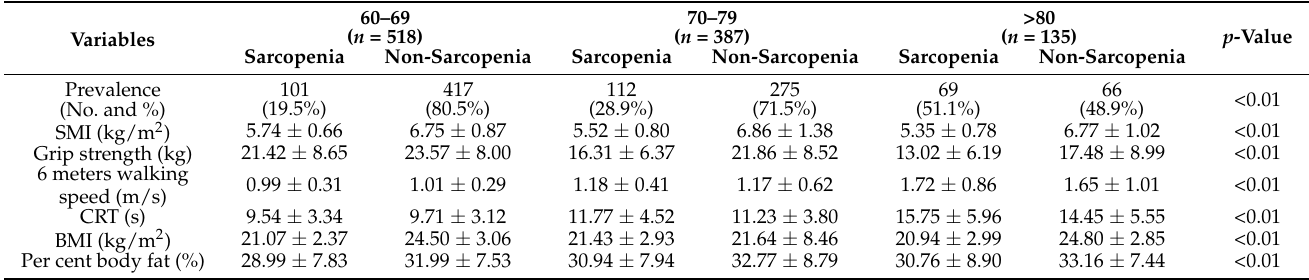
Table 2. Comparison of older adult-related indicators among different ages ( n = 1040).